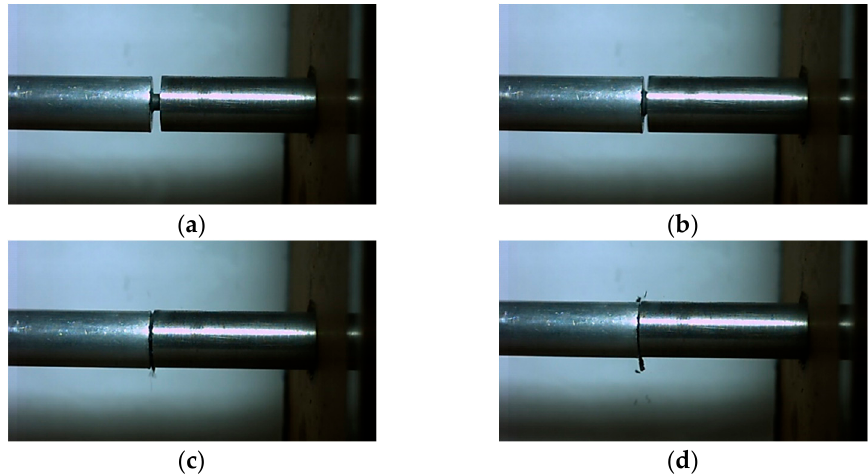
Figure 12. The interaction process between the bars and the sample at different times: ( a ) t = 0 μ s; ( b ) t = 333 μ s; ( c ) t = 666 μ s; ( d ) t = 999 μ s.